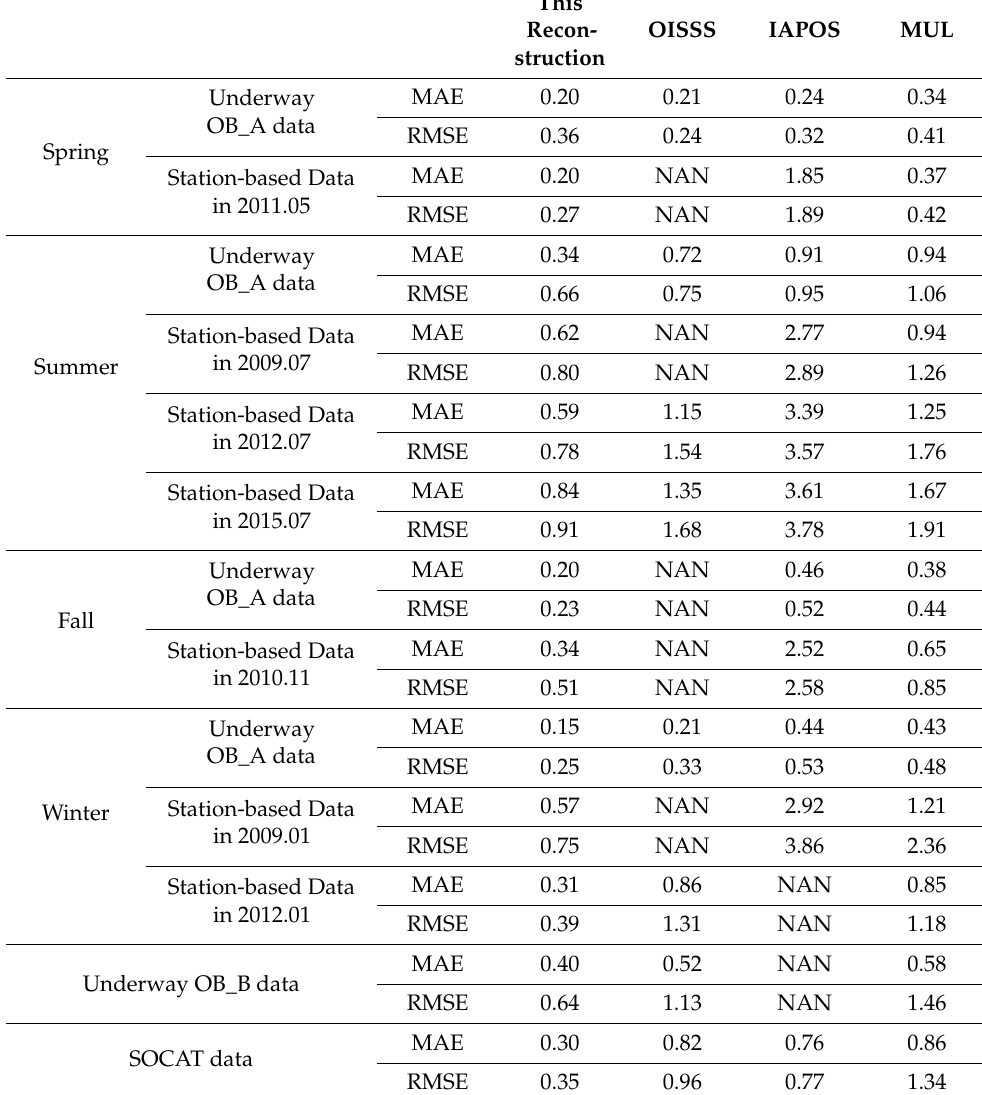
where y com stands for the datasets used for comparison (our reconstructions, OISSS, IAPOS, and MUL). Table 3. The mean absolute error (MAE) and root mean square error (RMSE) compared between the model-derived data and concurrent observational